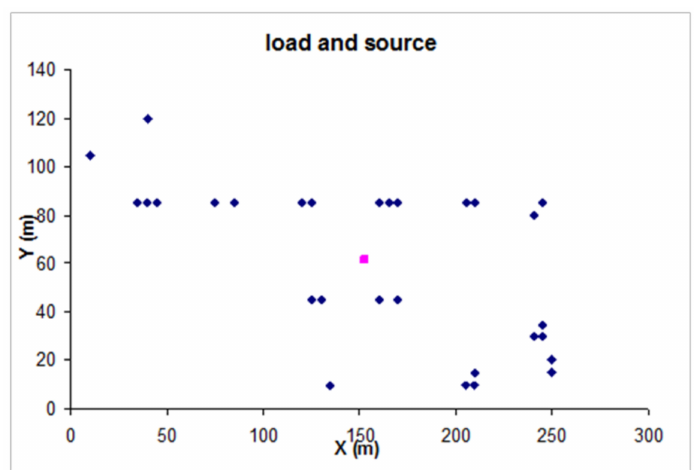
Figure 18. Spatial distribution load and optimal location of PV source obtained for the Rajmachi system.